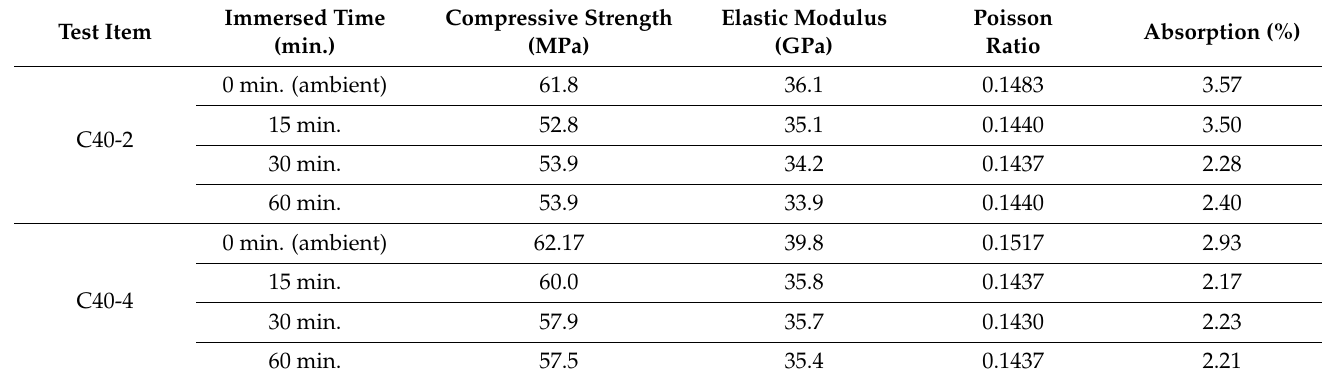
Table 11. Test results of compressive strength, elastic modulus, poisson ratio and absorption. Test